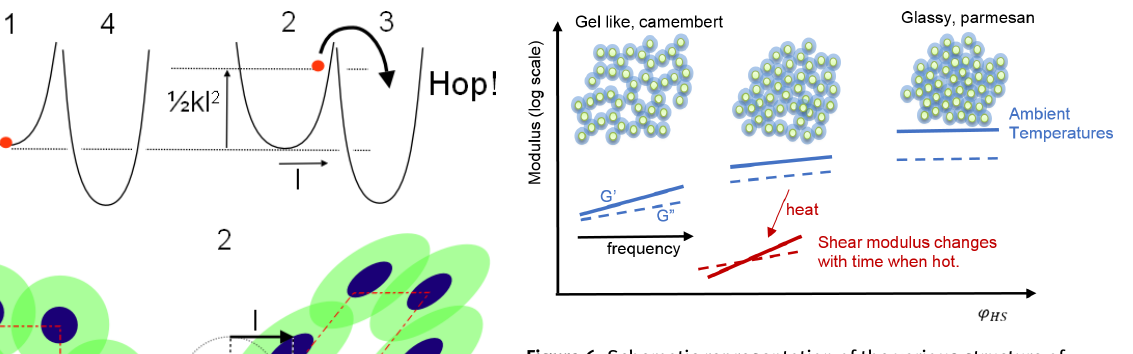
Figure 6: Schematic representation of the various structure of cheese as a function of volume fraction and the temperature and frequency dependence on the storage G ′ and loss G ′′ shear moduli. Solid blue and red lines represent shear storage modulus as a function of frequency at ambient and elevated temperature while dashed lines represent the shear loss